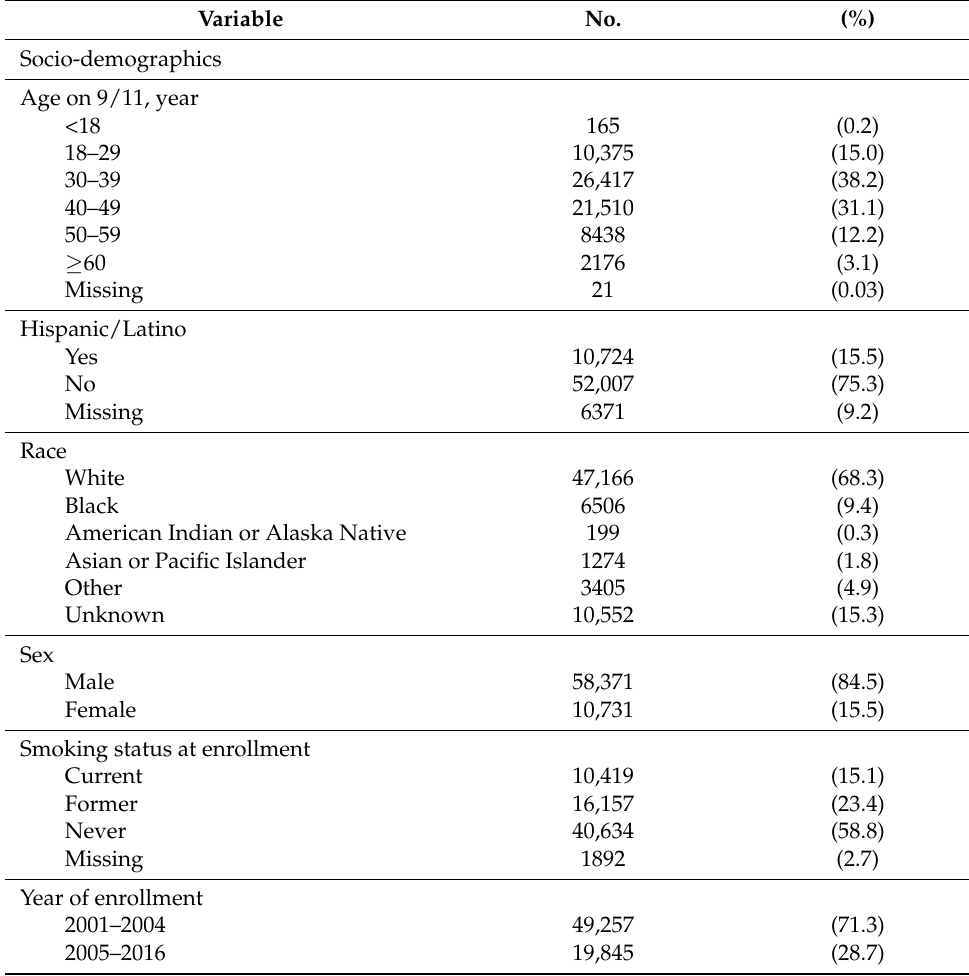
Table 4. Characteristics and WTC exposure of the combined cohort ( N =